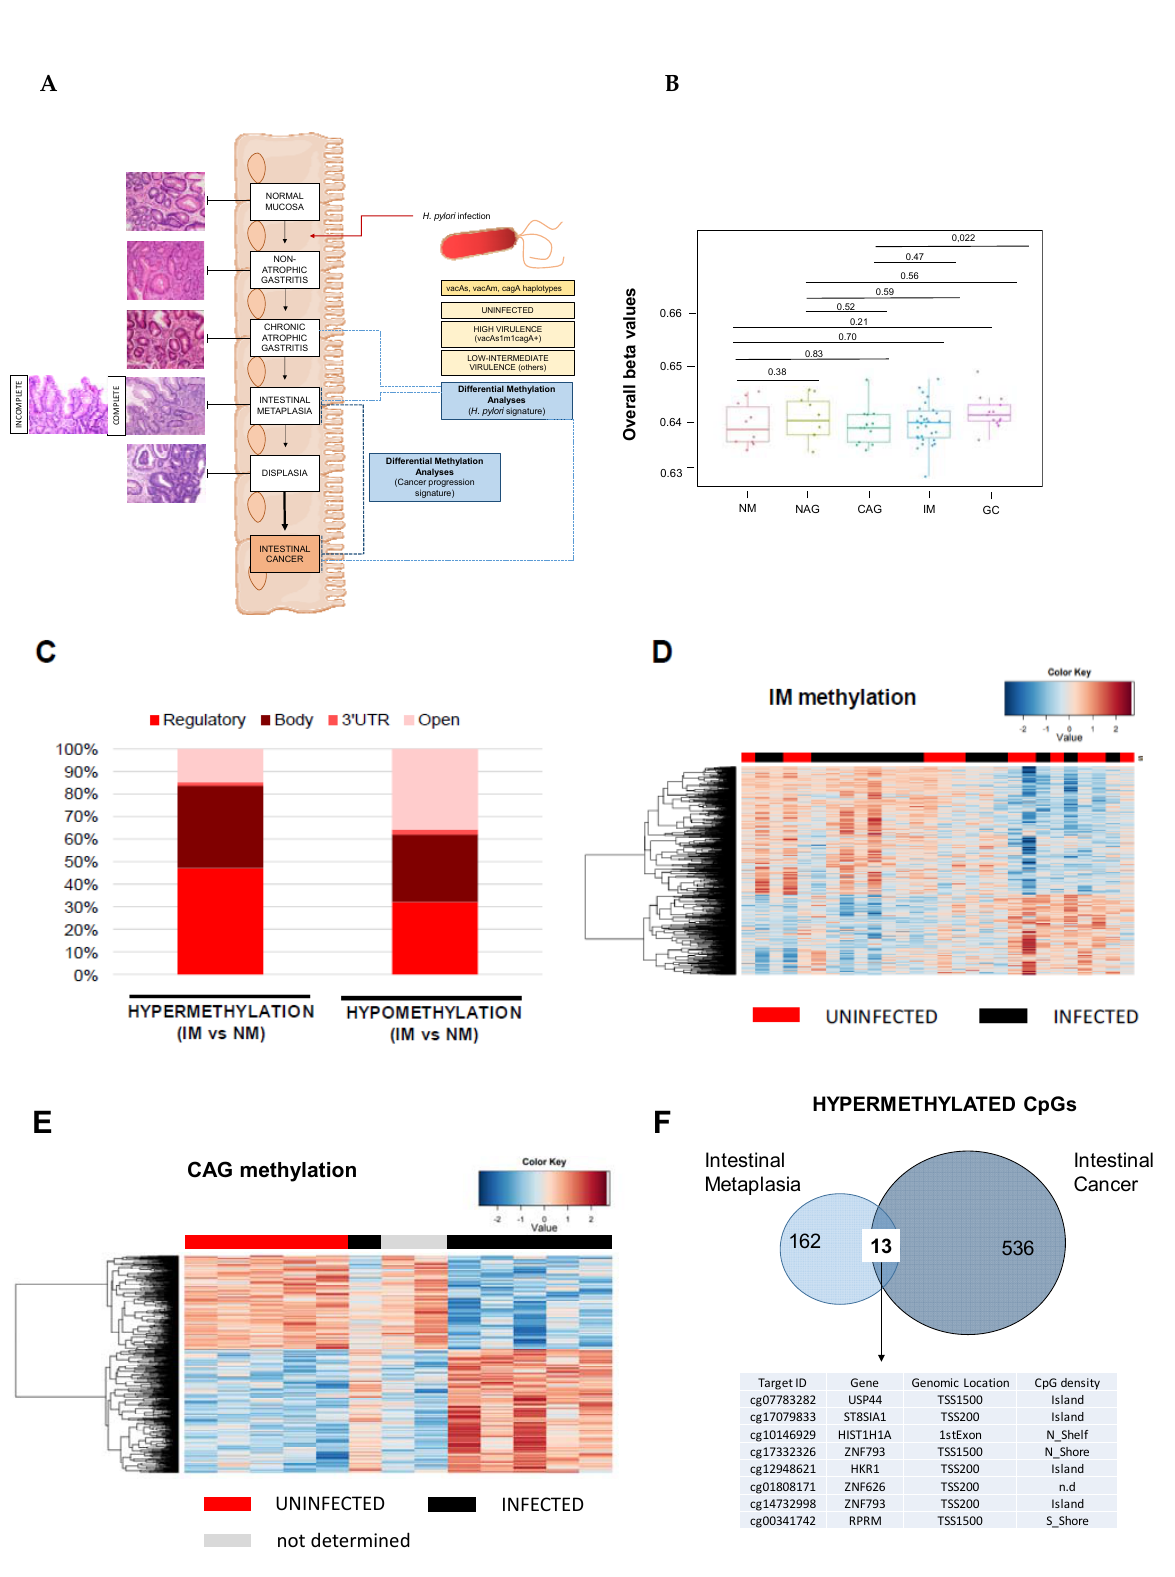
Figure 2. CpG methylation signature of the gastric precancerous cascade. ( A ) Schematic representation of the precursor lesion pathway. Two genome ‐ wide CpG methylation analyses were performed: (1) H. pylori ‐ related study to identify the